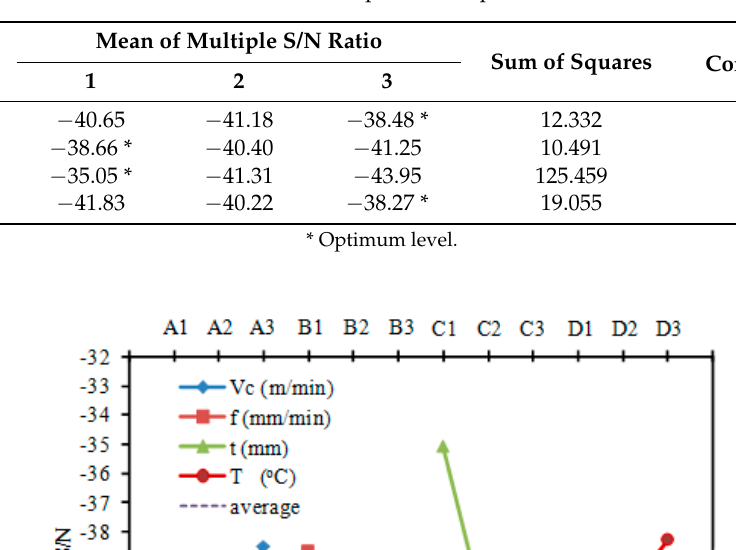
Table 9. Multiple S/N response.